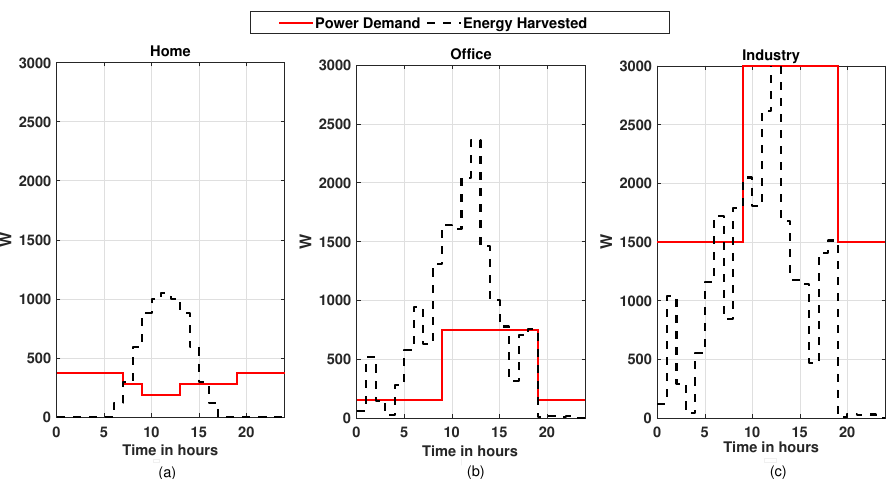
Figure 4. Electricity demand and harvested electricity of 24 h for the month of November, ( a ) for the home building, ( b ) for office building, and ( c ) for industry building.